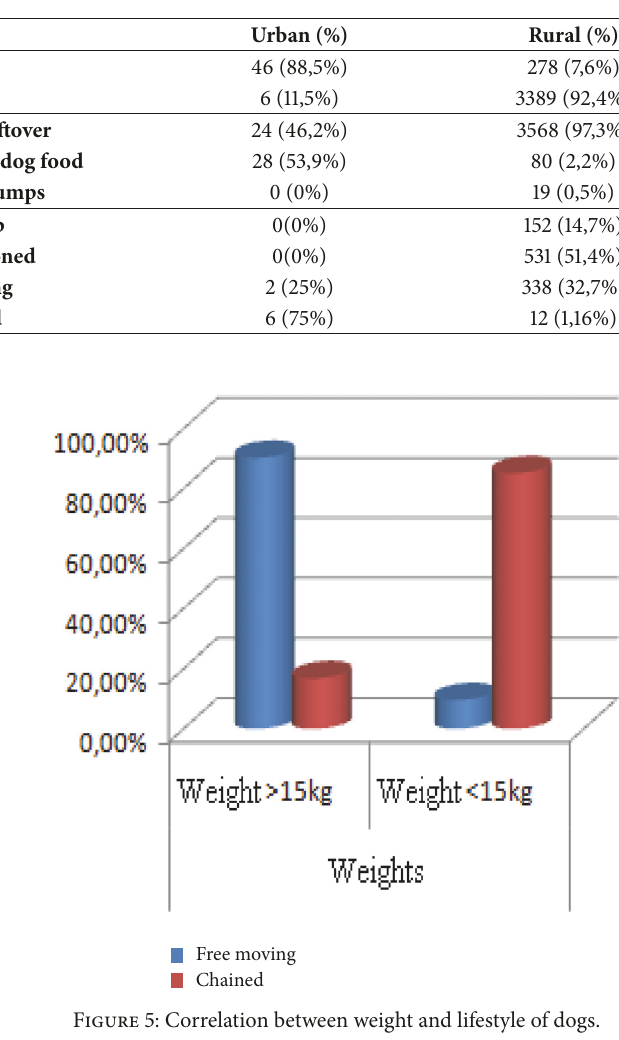
1:3.7 in Gwagwalada, Nigeria [19], 1:11 in South Africa [36], and 1:45 for an urban area in Zambia